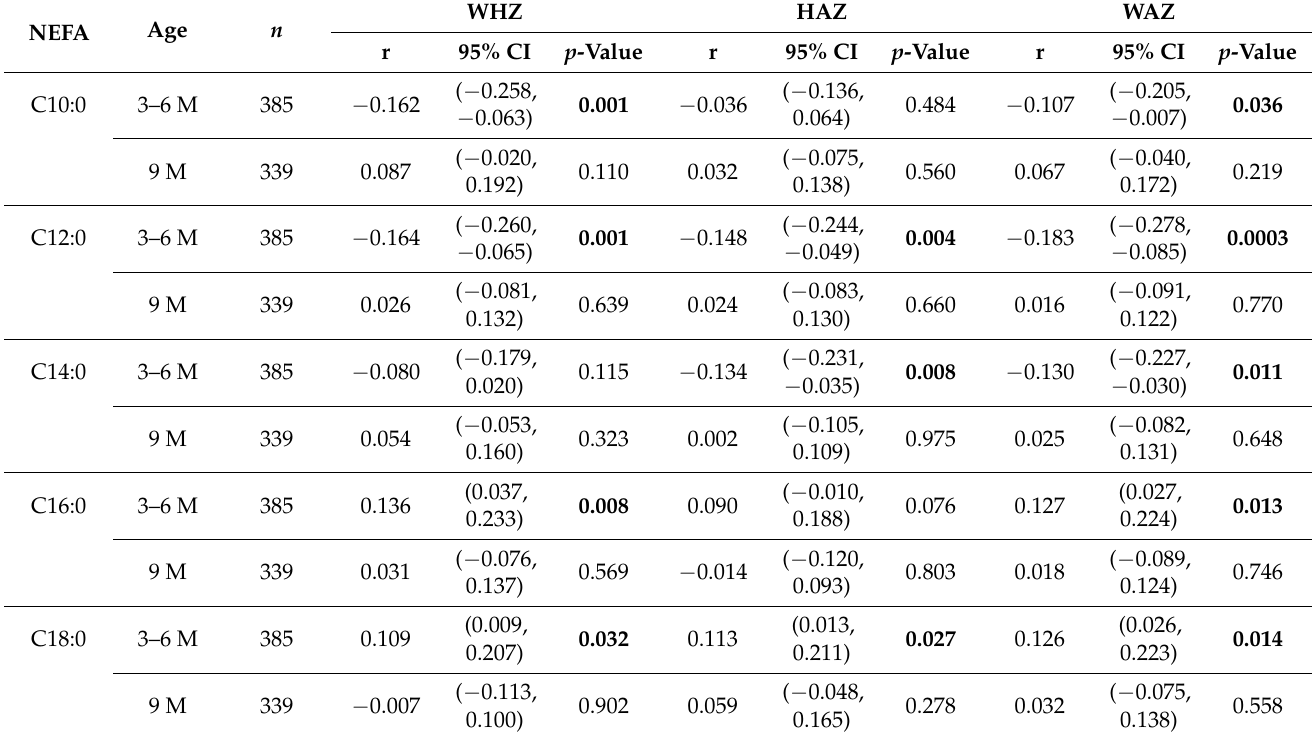
Table 3. Correlation between serum non-esterified fatty acid biomarkers (expressed as % composition) and growth among Pakistani undernourished and healthy children at 3–6 months and 9 months of